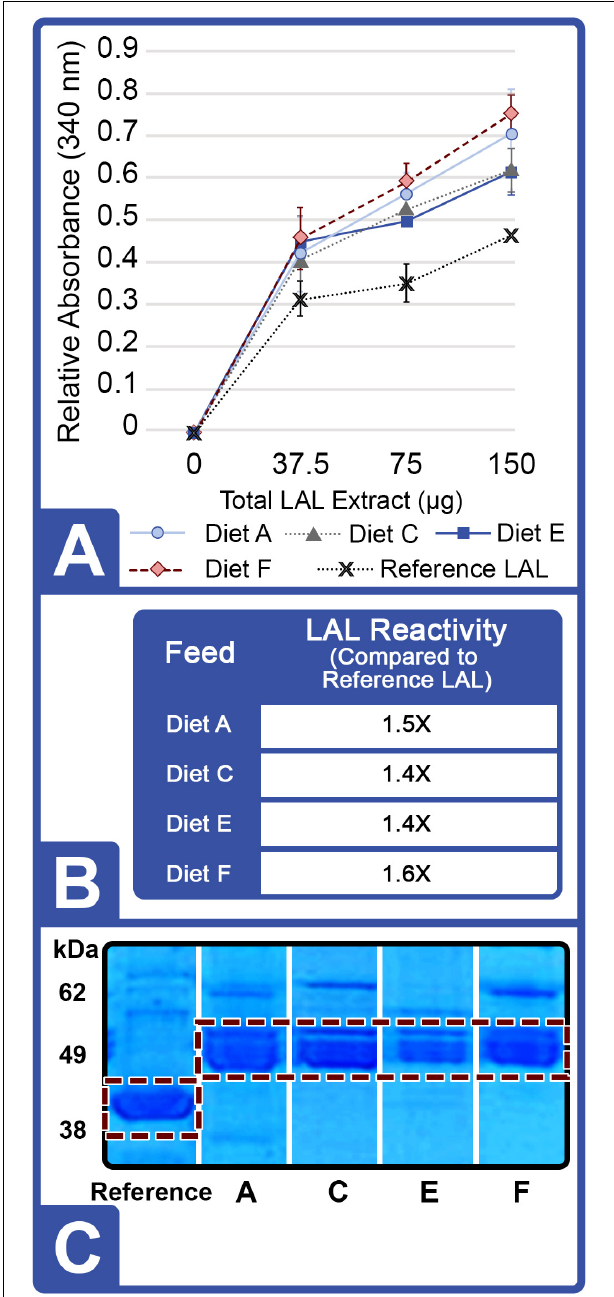
FIGURE 3 | Effect of diet on LAL reactivity to endotoxins (Feed Study 2). (A) Standard curves of aquaculture LAL reactivity to endotoxins by diet vs. reference LAL with 50 EU/mL LPS measured by absorbance at 340 nm. Results are represented as mean ± SD between individual LAL assays performed in triplicate. (B) Aquaculture LAL from each diet was normalized to reference LAL reactivity in the presence of 50 EU/mL of LPS. (C) SDS-PAGE of crude amebocyte lysates from aquaculture HSCs (Lanes 3 – 6) compared to reference LAL. Each sample was loaded at 5 µ g protein per lane on an 8% Tris-Glycine gel and stained with Coomassie blue; the See Blue+2 molecular weight marker was loaded as a ladder. Factor C (L-chain) is highlighted in white and appeared as a well-defined band at ∼ 43 kDa in reference LAL and at ∼ 52 kDa in the aquaculture